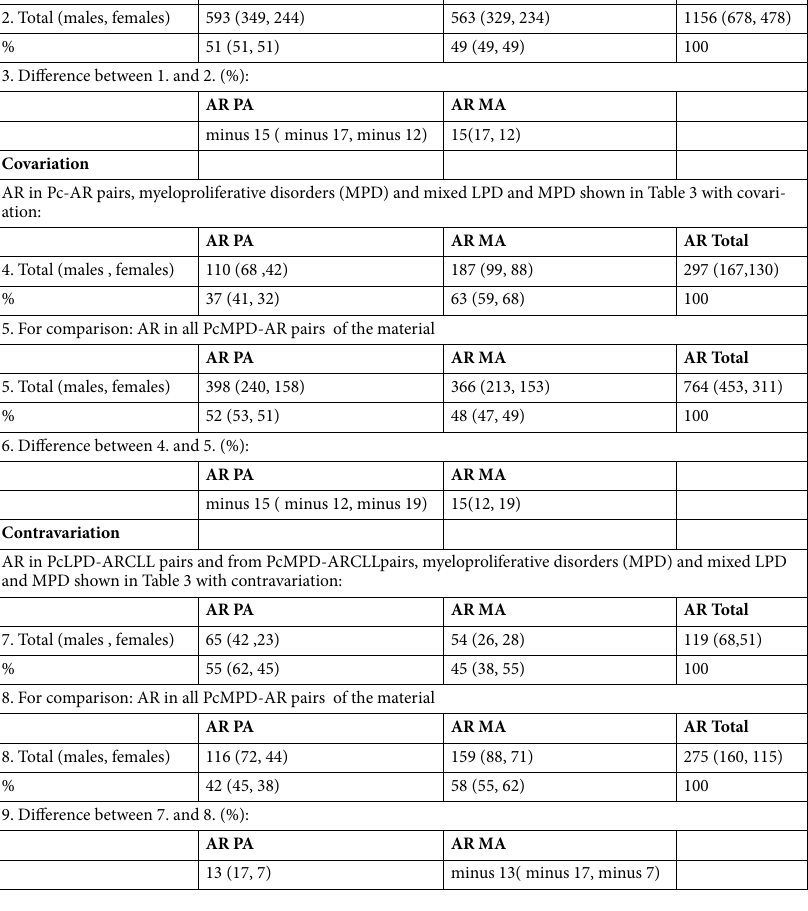
Table 4. Paternal (PA) and Maternal (MA) affiliation of Affected relatives (AR) in co- and contravariation (shown in Table 3), the Faroe